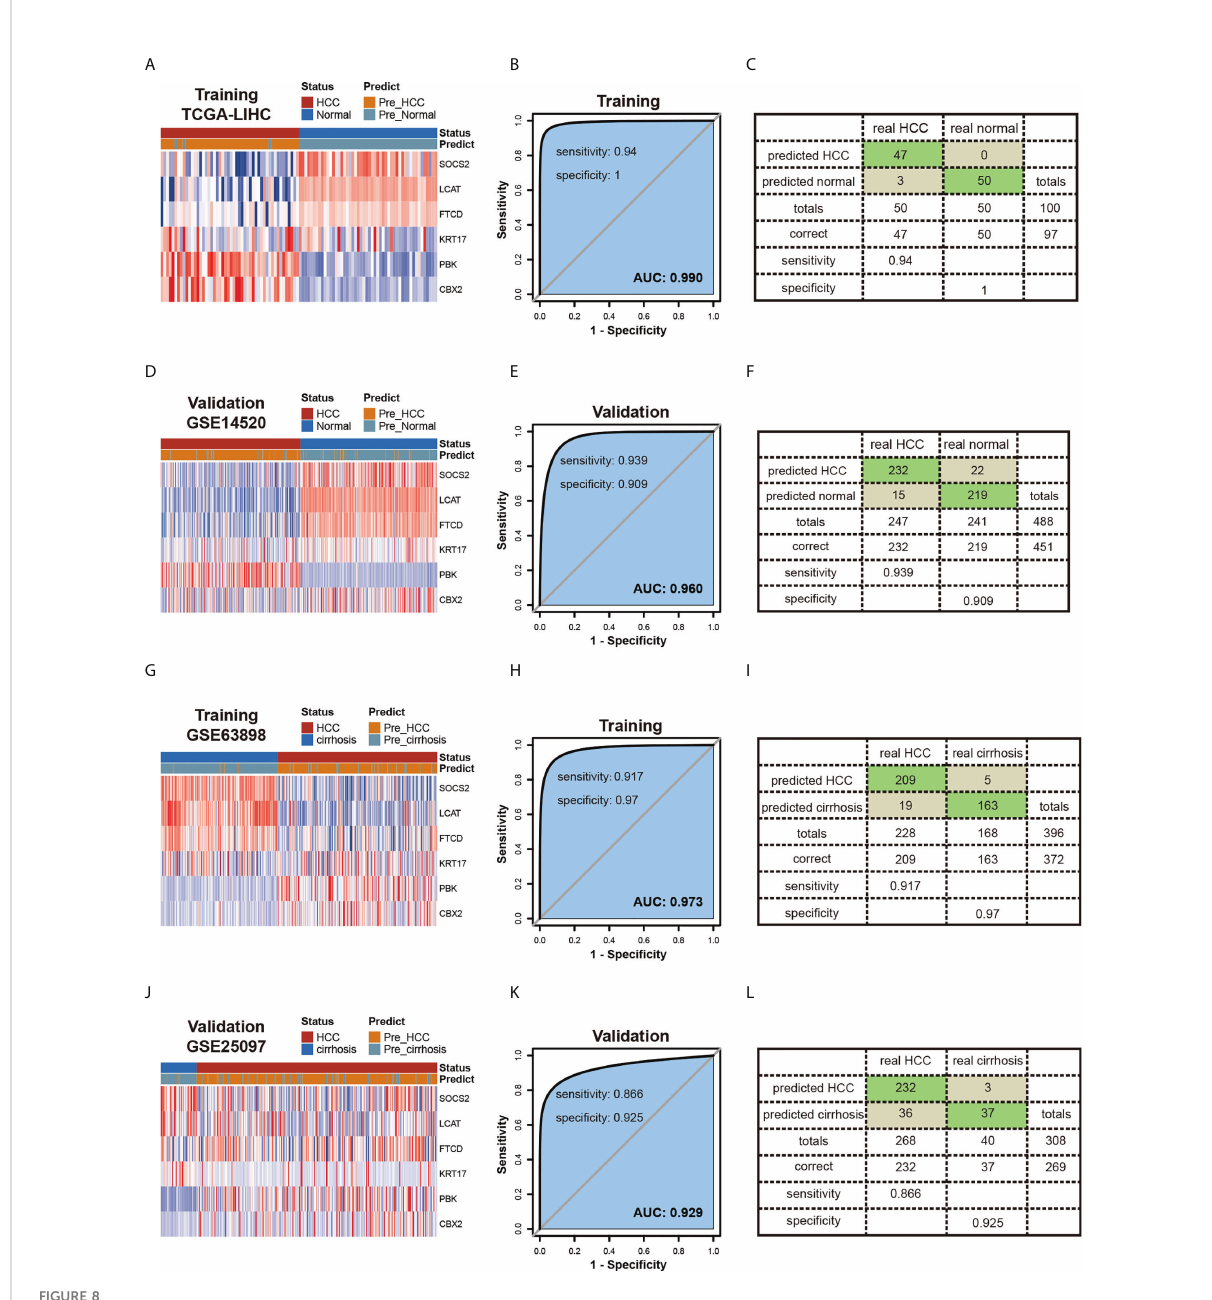
FIGURE 8 Constructing Diagnostic Models by six candidate genes. (A-F) Diagnostic model of HCC and normal tissues.Heatmaps of six genes expression between HCC and normal tissues in the training (A) and validation (D) testing cohorts.Receiver operating characteristic (ROC) curves and the associated areas under curves (AUCs) of the diagnostic prediction models in the training (B) and validation (E) testing cohorts.Confusion matrices were built from the diagnostic model prediction in the training (C) and validation (F) testing cohorts. (G-L) Diagnostic model of HCC and cirrhosis tissues.Heatmaps of six genes expression between HCC and cirrhosis tissues in the training (G) and validation (J) cohorts.Receiver operating characteristic (ROC) curves and the associated areas under curves (AUCs) of the diagnostic prediction models in the training (H) and validation (K) cohorts. Confusion matrices were built from the diagnostic model prediction in the training (I) and validation (L)